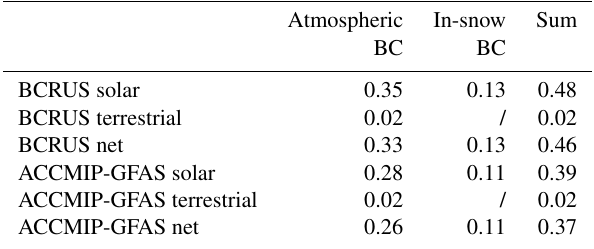
Table 5. Arctic (60–90 ◦ N) field means of TOA DRE of BC aver- aged over the years 2005—2009 (in Wm − 2 ) for the different emis- sion setups. The terrestrial effect of in-snow BC is not